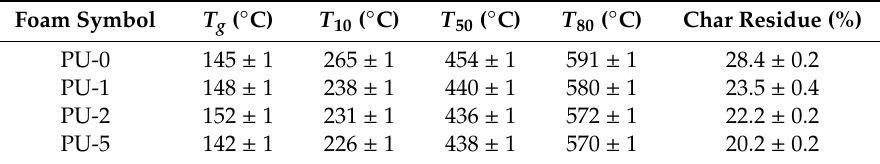
Table 5. Thermogravimetric analysis (TGA) results of PU composite foams investigated under nitrogen